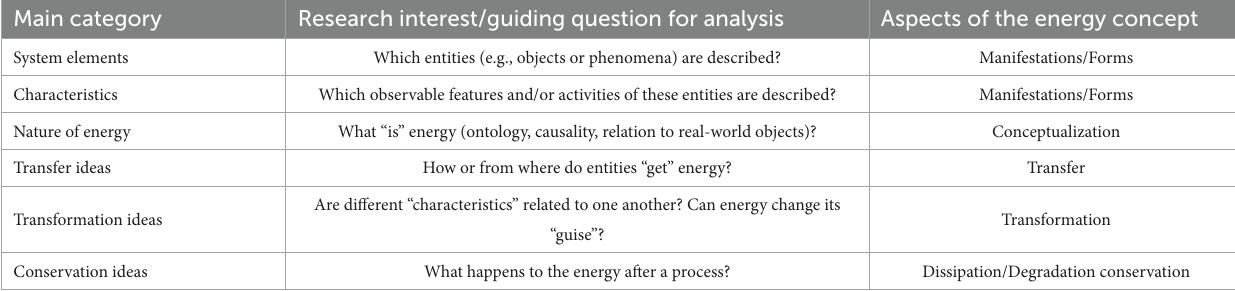
TABLE 1 Overview of the main categories, the research interest, and the relation to the scientific energy